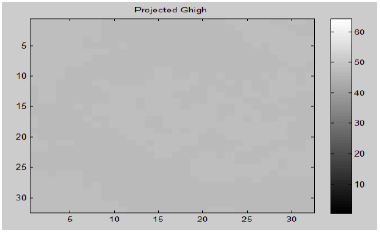
Figure 9a. Projected 32 × 32 pixels for red channel